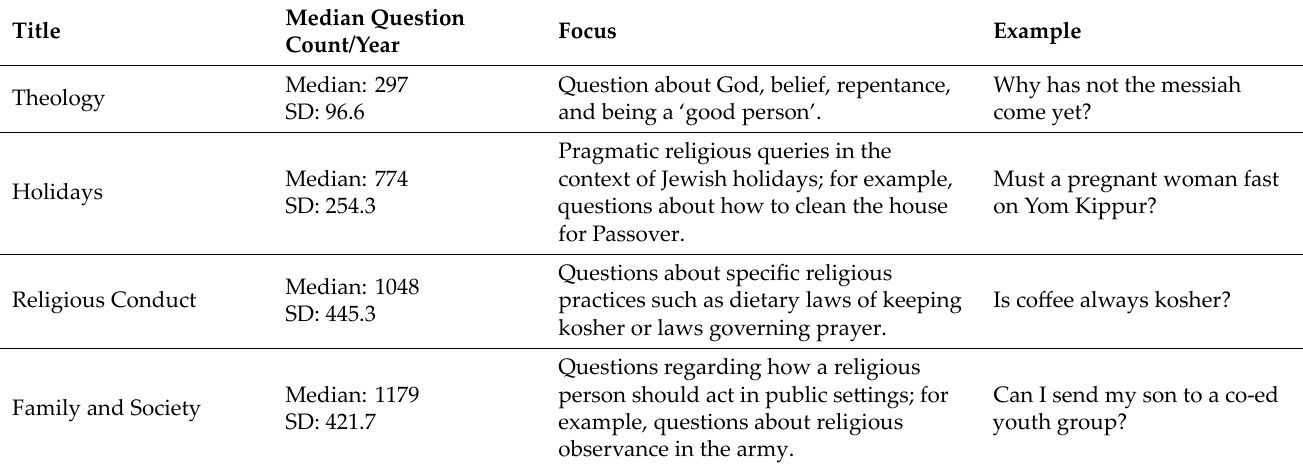
Table 1. Frequent categories for all questions asked on the site.